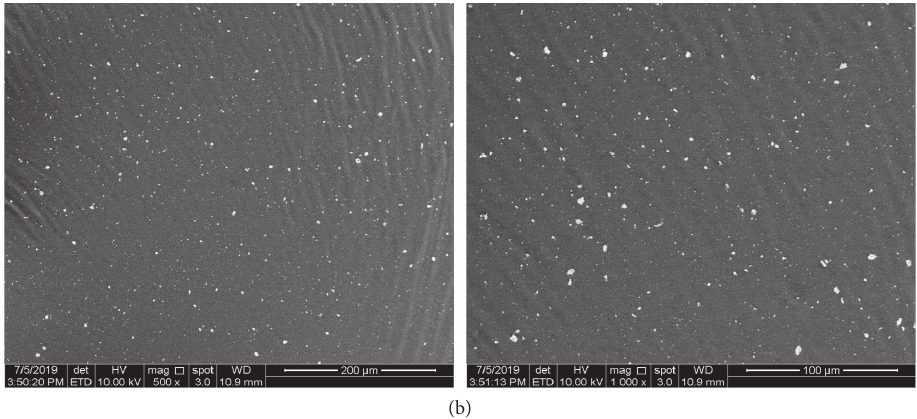
Figure 8: The micromorphology of nano-ZnO/nano-TiO 2 /copolymers SBS-modified asphalt. (a) Unaged. (b) Aged.